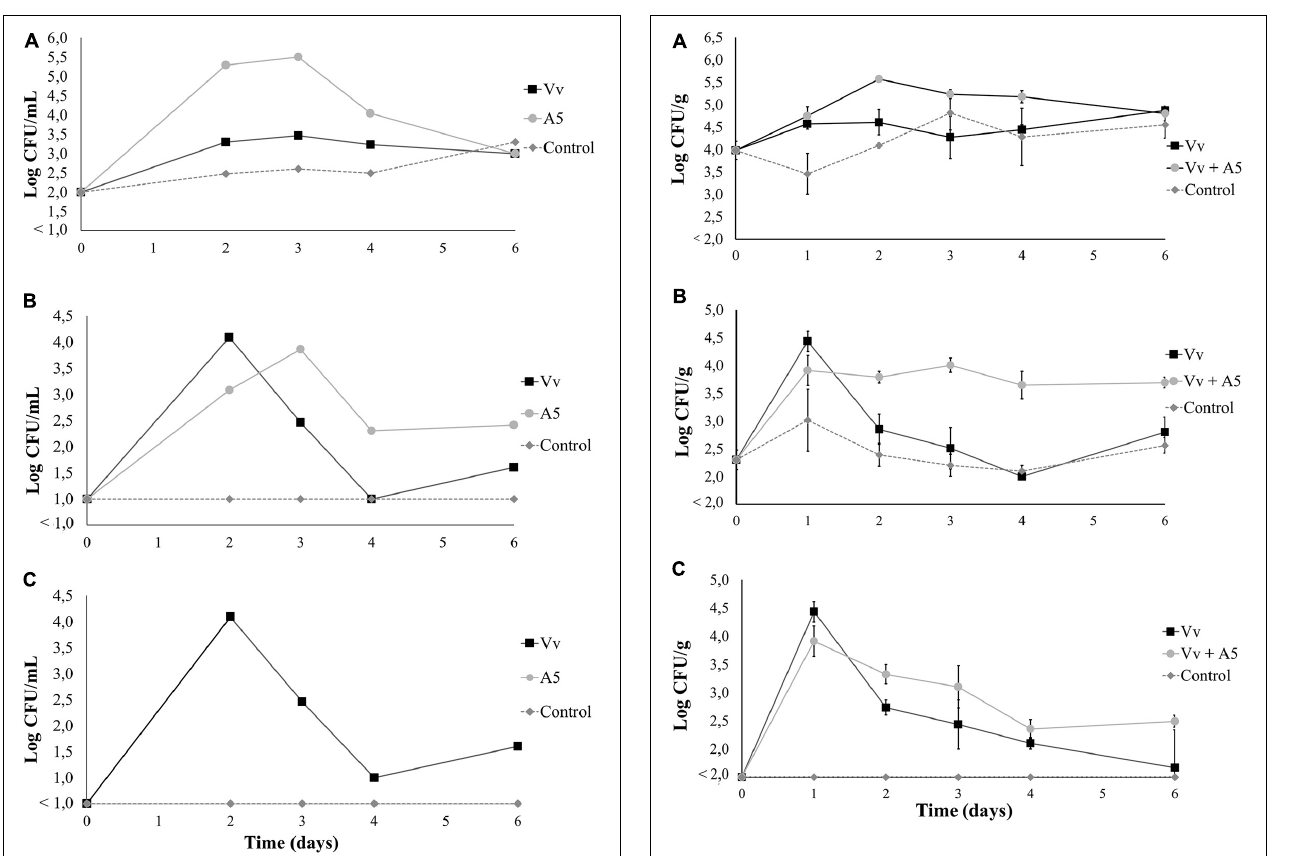
FIGURE 5 | Total aerobic bacteria (A) , total vibrio (B) , and Vibrio vulnificus (C) levels in seawater from bioassay 1 (evaluation of colonization potential). Three treatments are shown: Vv inoculated with V. vulnificus only ( (cid:4) ), A5 inoculated with A5 only ( • ), and control ( (cid:7) dotted line). The absence of colonies is represented as below the limit of detection (LOD) ( < 1.0 log CFU/g).